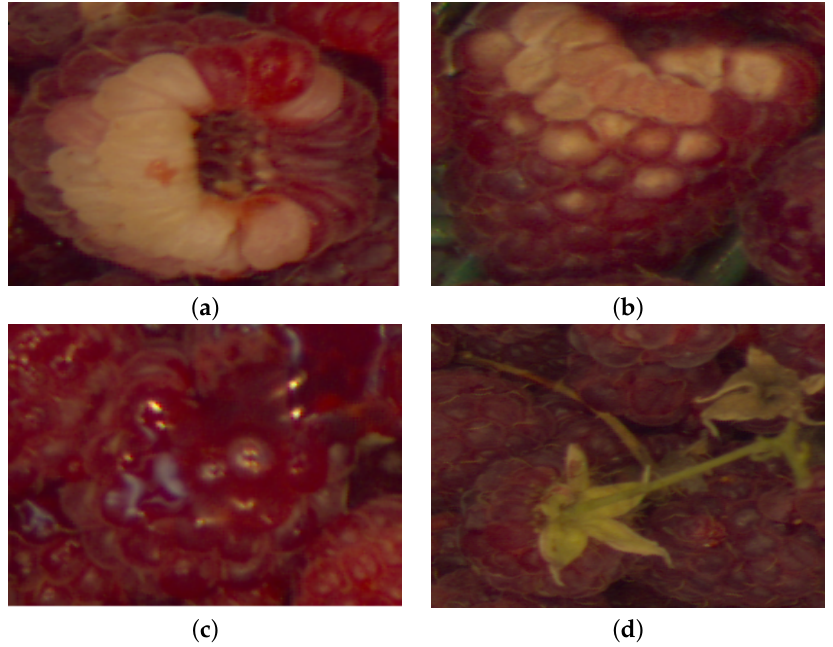
Figure 3. Raspberries’ diseases and defects used in this database. ( a ) Albinism. ( b ) Fungus-Rust. ( c ) Over-ripeness. ( d ) Peduncle. Note that to the inexpert eye, the albinism disease can be confused with the over-ripeness